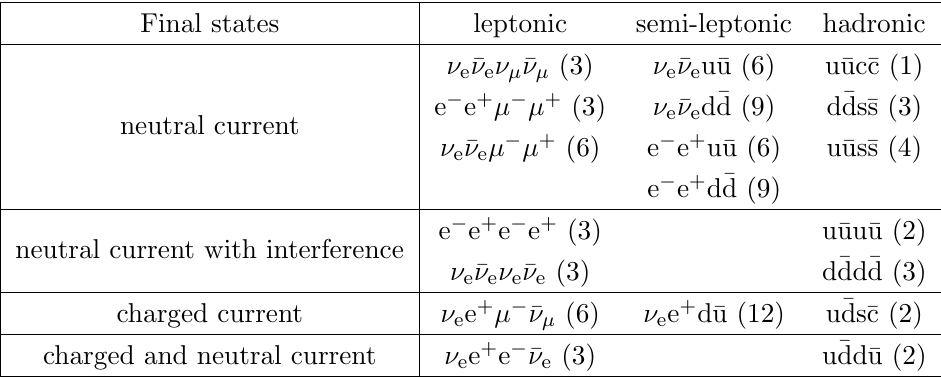
Table 1 . The possible (cid:12)nal states for the decay h by the intermediate gauge boson and the number of lepton pairs. Final states that di(cid:11)er only by generation indices, but have the same diagrams have identical matrix elements and are only stated once. The multiplicity of a (cid:12)nal state obtained by changing the generation indices is given in